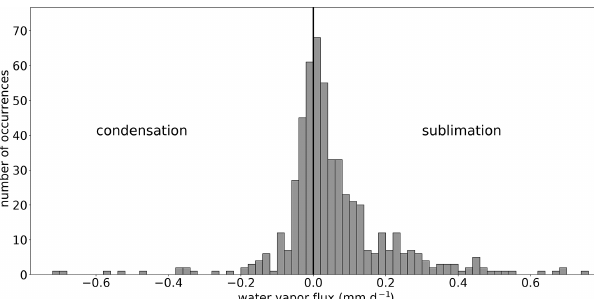
Figure 5. Histogram of daily water vapor flux (values > 0 indicate sublimation and values < 0 indicate condensation) for all three win-